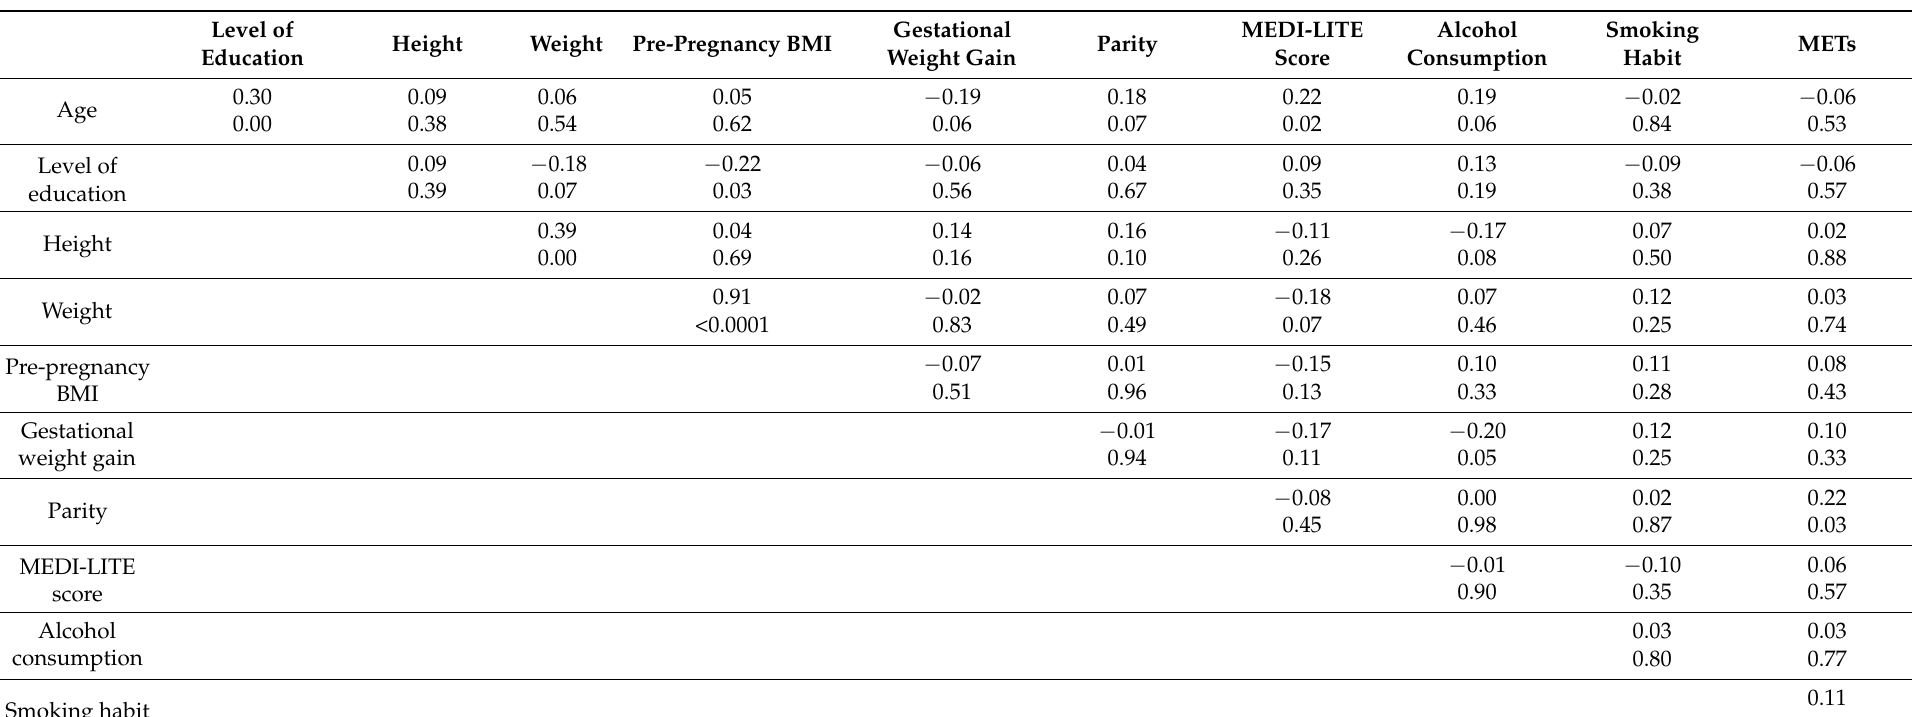
Table 2. Correlation between demographic, clinical and lifestyle variables in the overall sample ( n = 100); data are presented as Spearman’s correlation coefficients and p values. Level